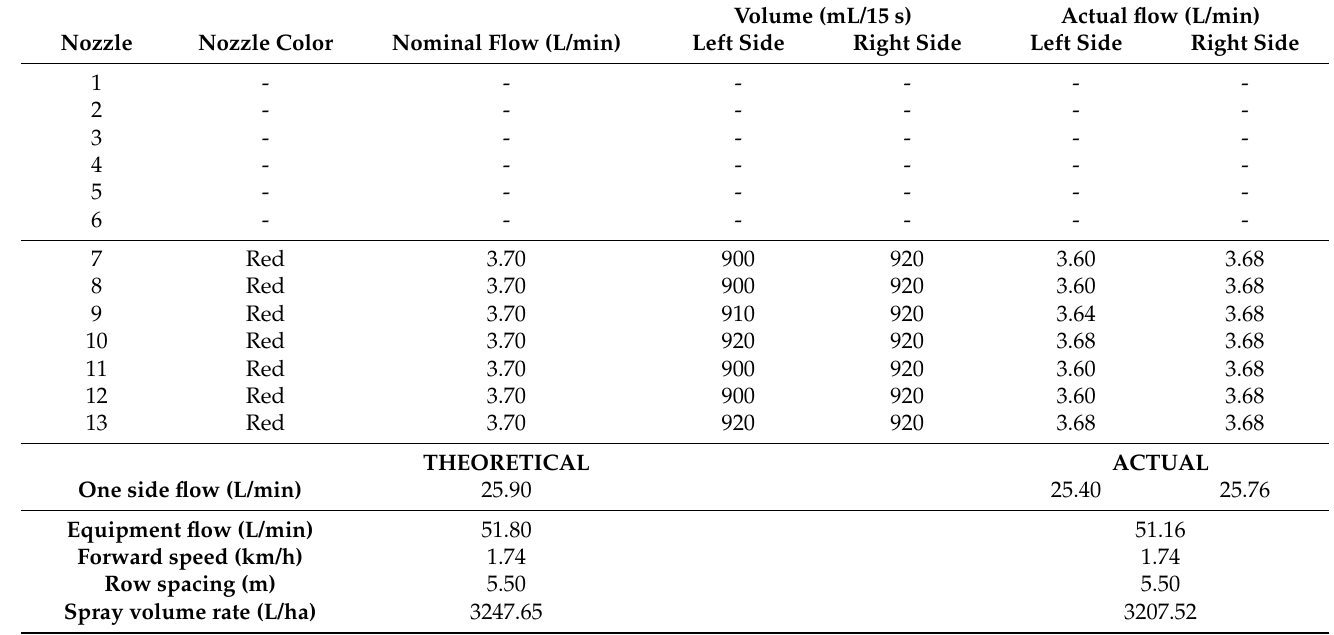
Table A24. Selection and calibration of nozzles for the C1 sprayer, with the following configuration: No adjusted to the vegetation/High & Low fan speed/High spray volume rate/Drift-reducing nozzles (Coarse)/Pressure: 16